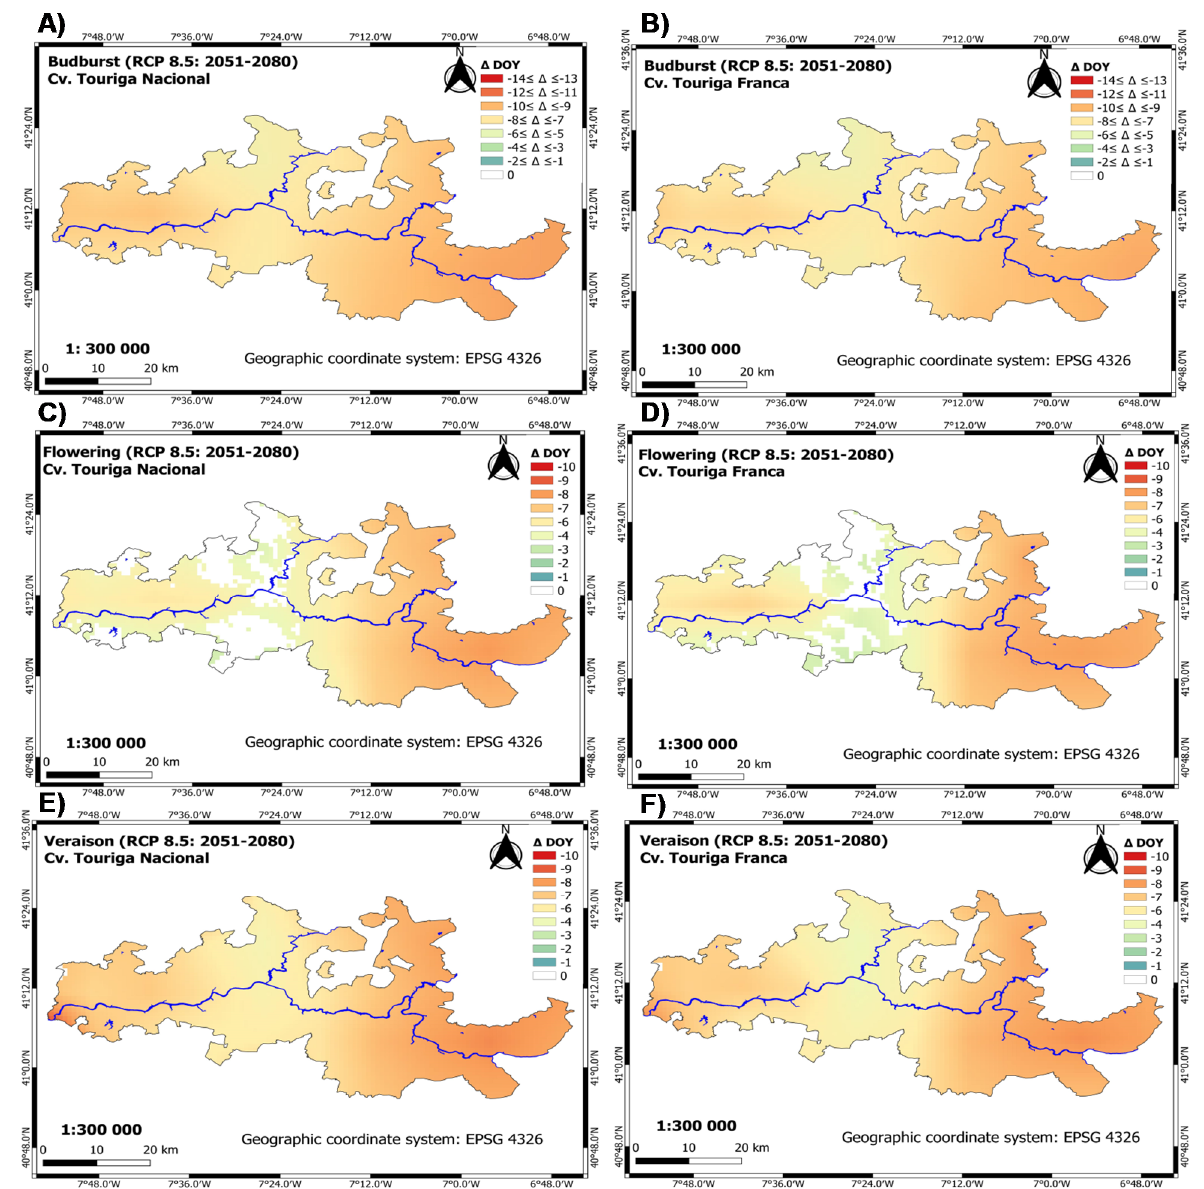
Figure 3. Difference between future and historic (RCP8.5) phenology maps covering the entire Douro Demarcated Region. A color scale represents the differences between future and historic (( ∆ DOY)) for each phenological stage, namely budburst ( A , B ), flowering ( C , D ) and veraison ( E , F ) in the varieties cv. Touriga Nacional (left) and Touriga Franca (right). The Douro river and main tributaries are also outlined (thick blue